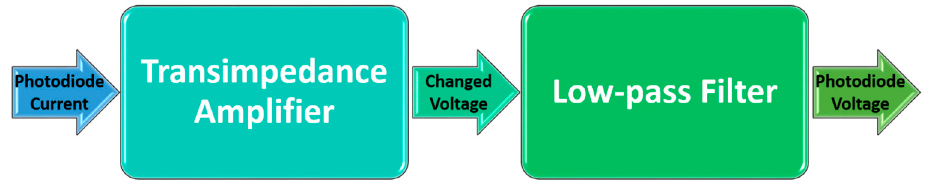
Figure 3. Block diagram of the electronic stages designed for the photodiodes of the sensor pads.